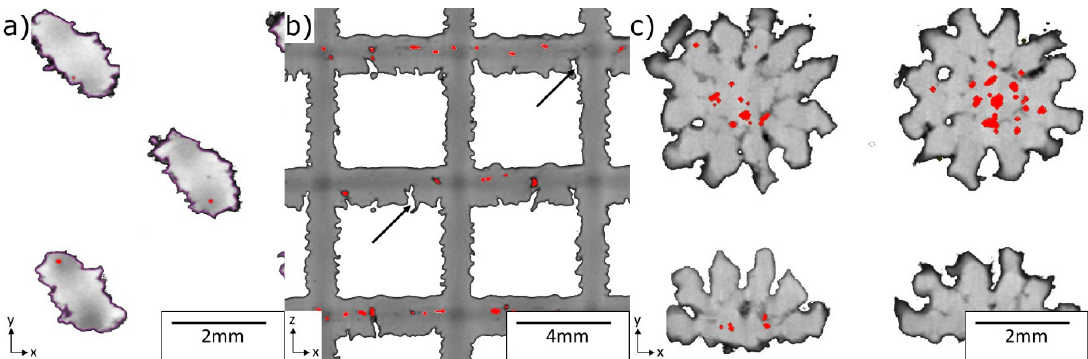
Figure 7. Sections of the reconstructed lattice volumes showing the metal and pore in red: ( a ) Diamond ‐ like lattice in the z direction at 12.3 mm, see Figure 4; ( b ) nodes between horizontal and vertical trusses for the Cubic lattice in the x – z plane showing tunnel ‐ like pores highlighted by arrows in black and ( c ) nodes of the re ‐ entrant lattice in z direction at 9.6 mm showing pore “colonies”.